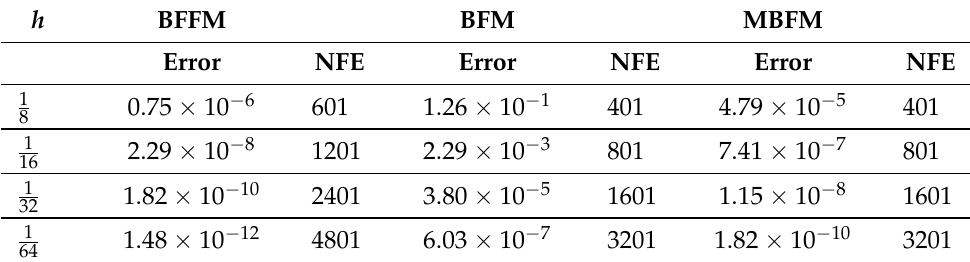
Table 2. Data for Example 2 with ω = 5, ε = 10 − 3